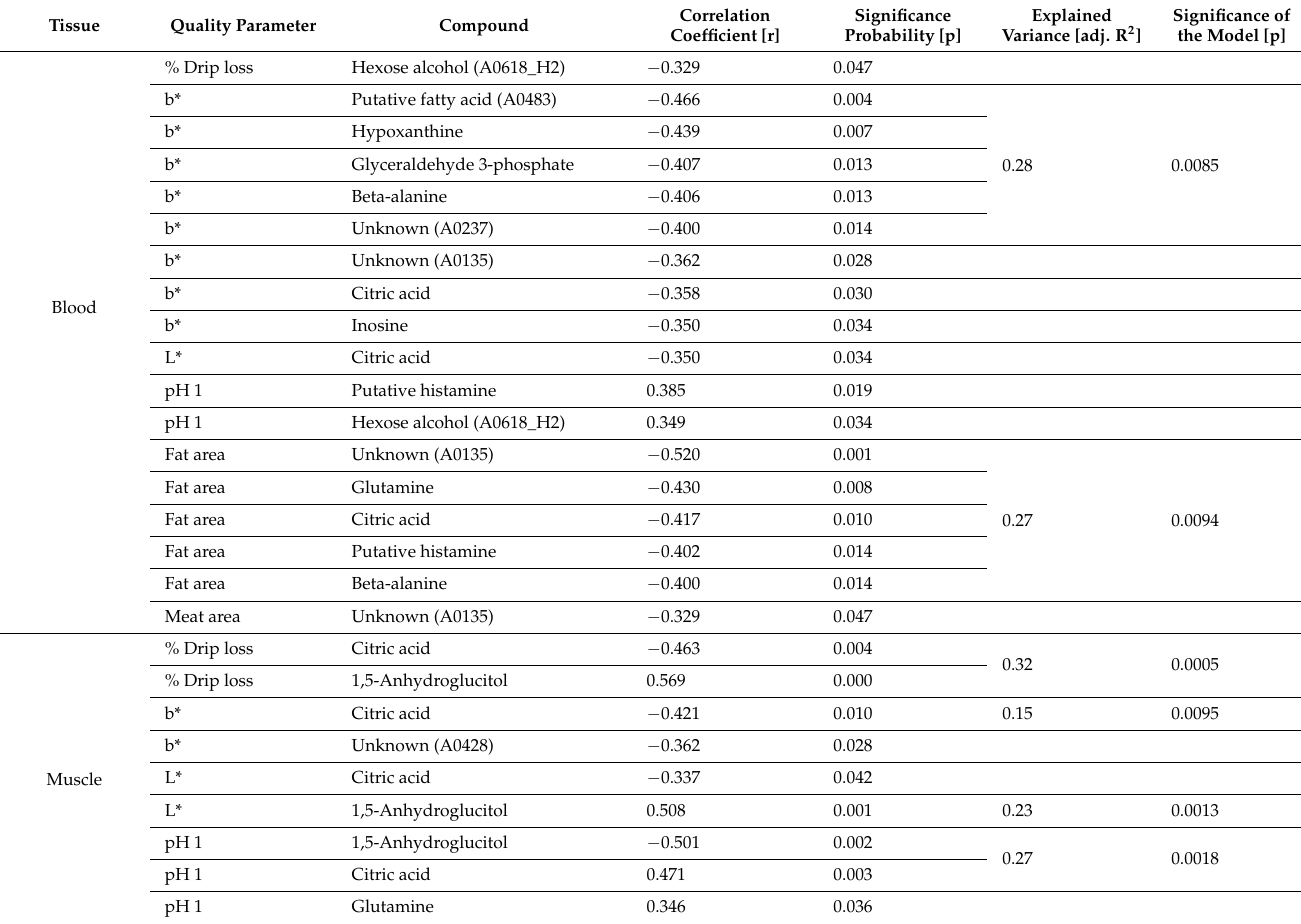
Table 4. Pearson correlation coefficients (r) of quality parameters to compounds that showed significant differences between boars and gilts, and multiple regression coefficients with predictors having an r > 0.4 (at least moderate correlation). For the explained variance [R 2 ] the adjusted value is presented.